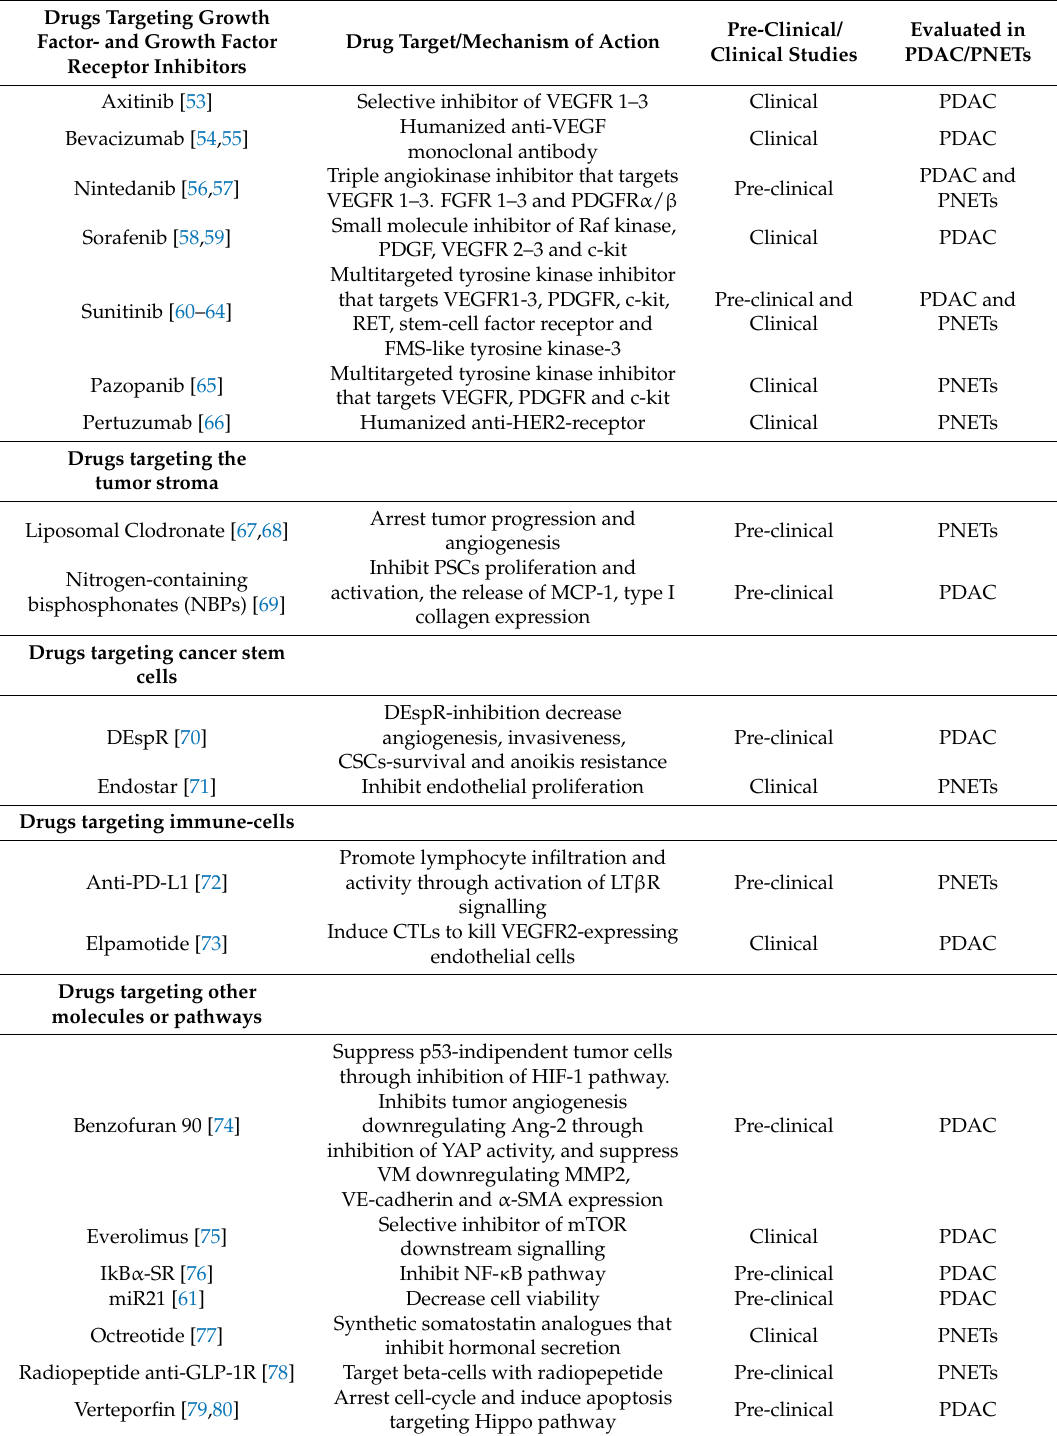
Table 2. Drugs targeting directly or indirectly angiogenesis in pancreatic